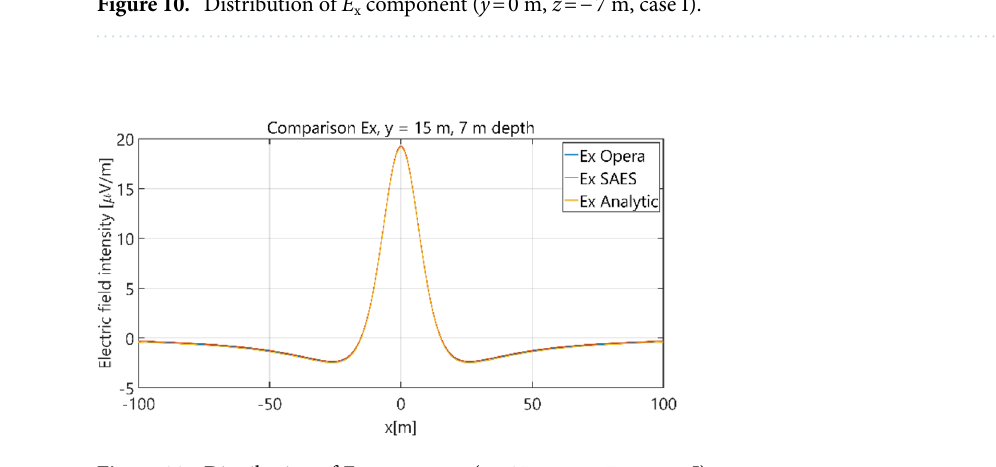
Figure 11. Distribution of E x component ( y = 15 m, z = − 7 m, case I).